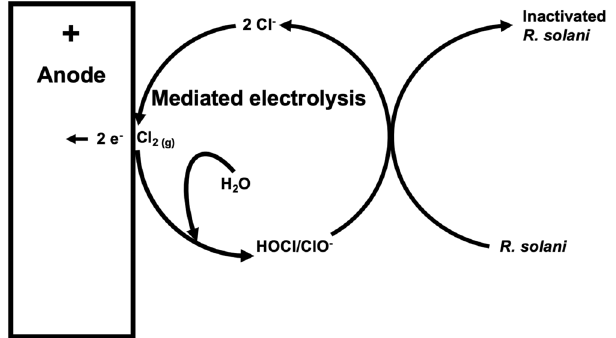
Figure 1. Schematic showing proposed mechanisms of pathogen inactivation with an emphasis on the cycle of reactions constituting regenerative in situ electrochemical hypochlorination (mediated electrolysis). Direct oxidation and other unknown inactivation mechanisms (e.g., Electroporation, high acidity near the electrode surface and/or production of hydrogen peroxide) require additional research to characterize. Regenerative mediated electrolysis, in which chloride ions are transformed to free chlorine forms (e.g., Hypochlorous acid), neutralizes pathogens and in the process releases chloride ions back to the solution. The chloride ion migrates back to the anode through electrostatic migration where it once again can be transformed to free chlorine forms leading to further pathogen